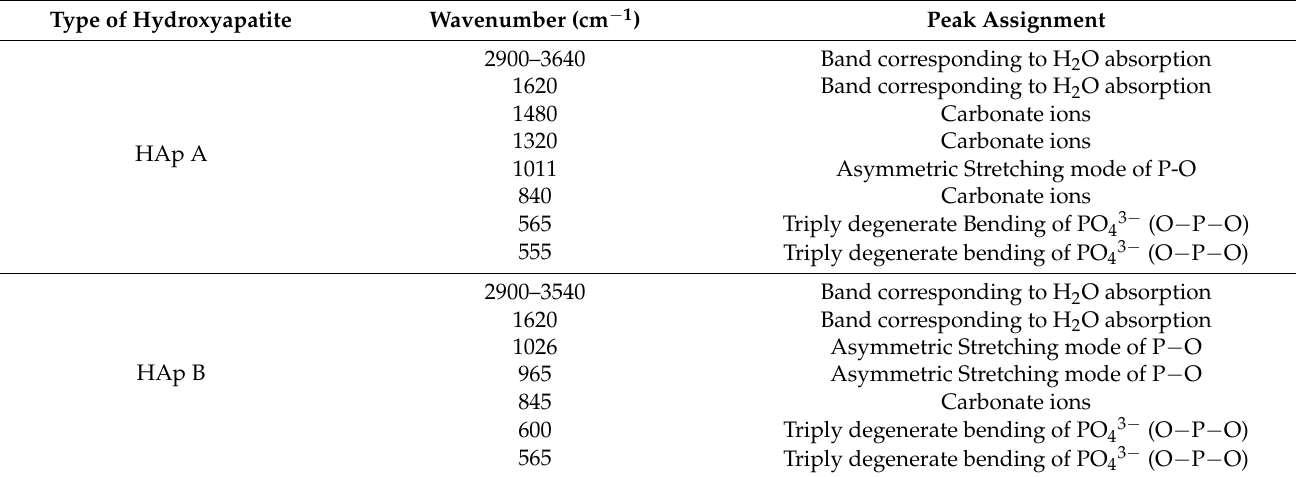
Table 5. IR bad assignment of